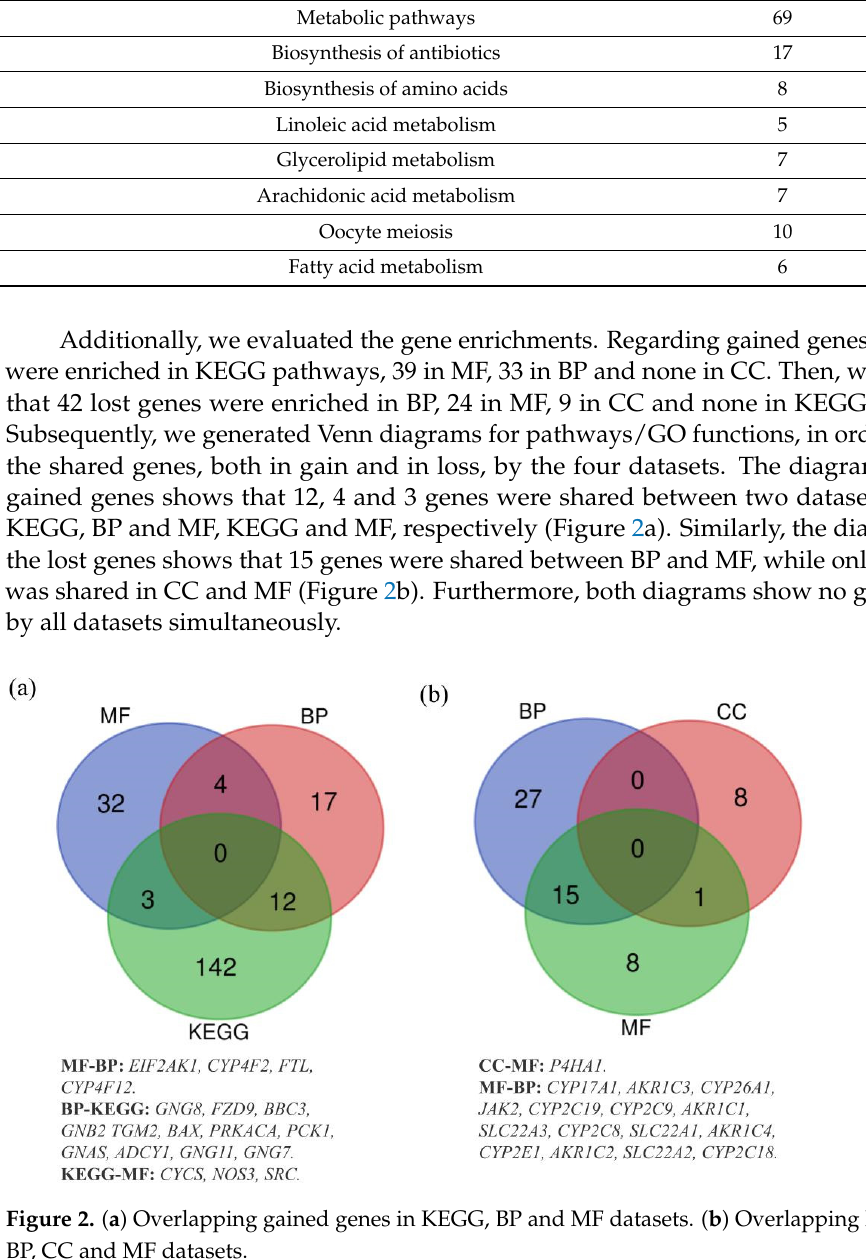
Table 7. Report of Pearson correlation values (R) for TC ‐ PBZ ‐ genomic profiles comparison. GPs are ranked into three groups: ones with a very strong correlation between the pair of genomic profiles (R ≥ 0.80); ones with a moderately strong correlation (0.40 ≤ R < 0.80); ones with a low correlation (R < 0.40). The statistical significance for each pair of correlations was calculated consulting the Table of Critical Values for Pearson’s R. N: total number of CNAs; DF: degree of freedom (N ‐ 2). Level of significance for a two ‐ tailed test α = 0.05. * indicates statistically significant test. GP